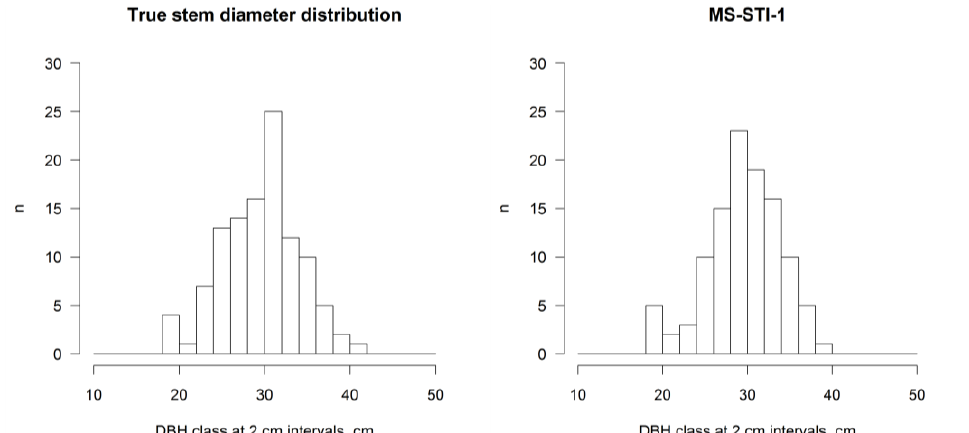
Figure 2. True and predicted stem-diameter